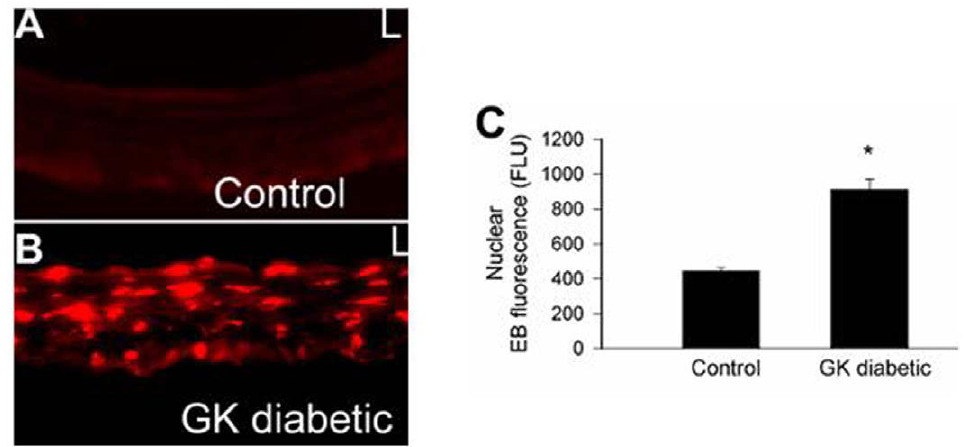
Figure 3. DHE fluorescence staining for superoxide. A. 9 month-old Wistar aorta, B. 9 month-old GK aorta. C. Quantification of DHE staining. Images were collected with a CoolSnap CCD camera attached to an Olympus BX60 microscope. Values are mean 6 SEM of 4 animals. * p , .05 compared to Wistar.